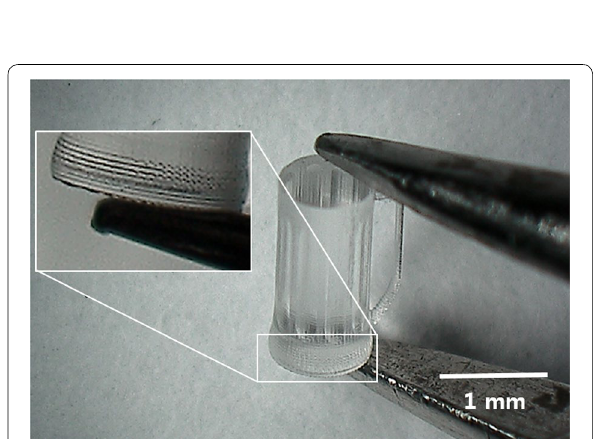
Fig. 4 Small beer mug handled with forceps (1.2 mm in width, 2 mm in height, a volume of 3